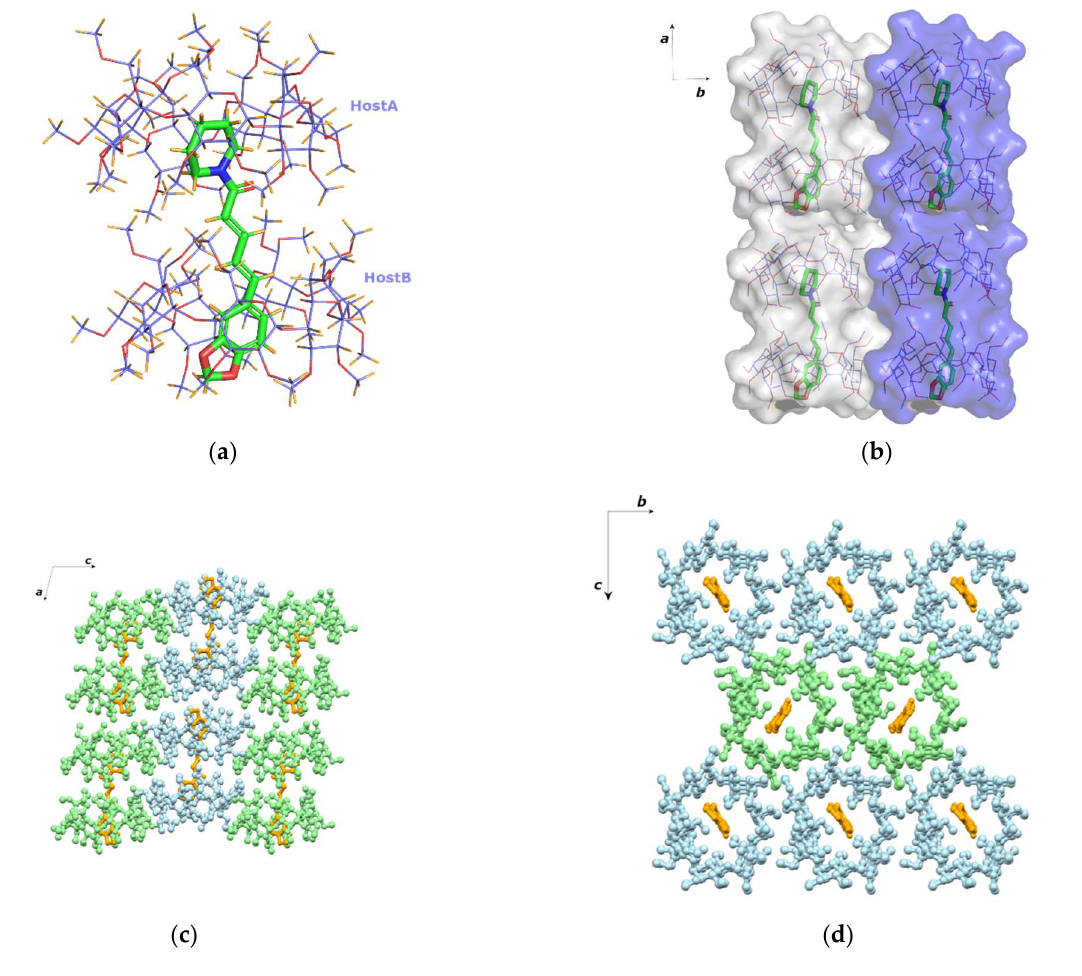
Figure 5. ( a ) In the asymmetric unit, one piperine (PN) molecule (shown as green sticks) is fully encapsulated inside two TM- β- CD host molecules (hostA and hostB shown as purple lines). ( b ) The projection of the ab plane reveals two parallel columns. ( c ) The projection of the ac plane reveals antiparallel columns. ( d ) The crystal packing is characterised by the formation of channels along the a axis.